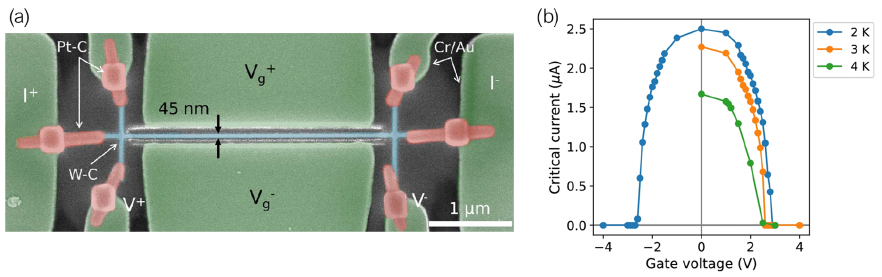
Figure 7. ( a ) Artificially colored SEM image of a W-C nanowire placed between two gate electrodes. ( b ) Critical current dependence of the nanowire with the side-gate voltage. Reprinted from [141], under CC BY